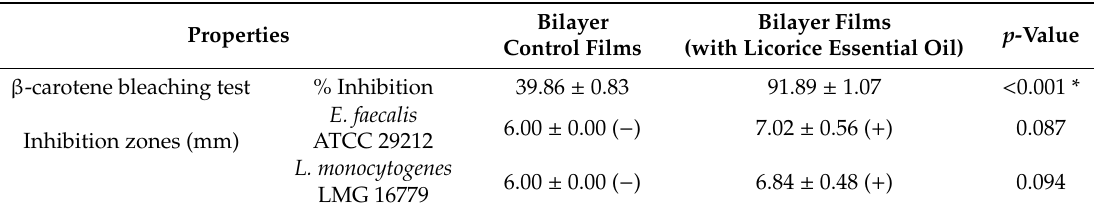
Table 4. Antioxidant activity ( β -carotene bleaching test) and antibacterial properties of bilayer